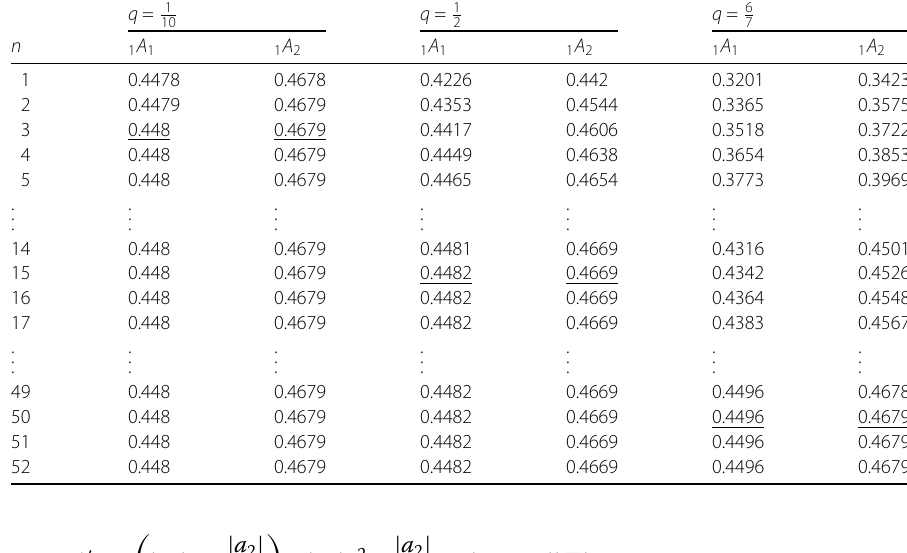
Table 1 Some numerical results for 1 A 1 and 1 A 2 in Example 1 for q = 1